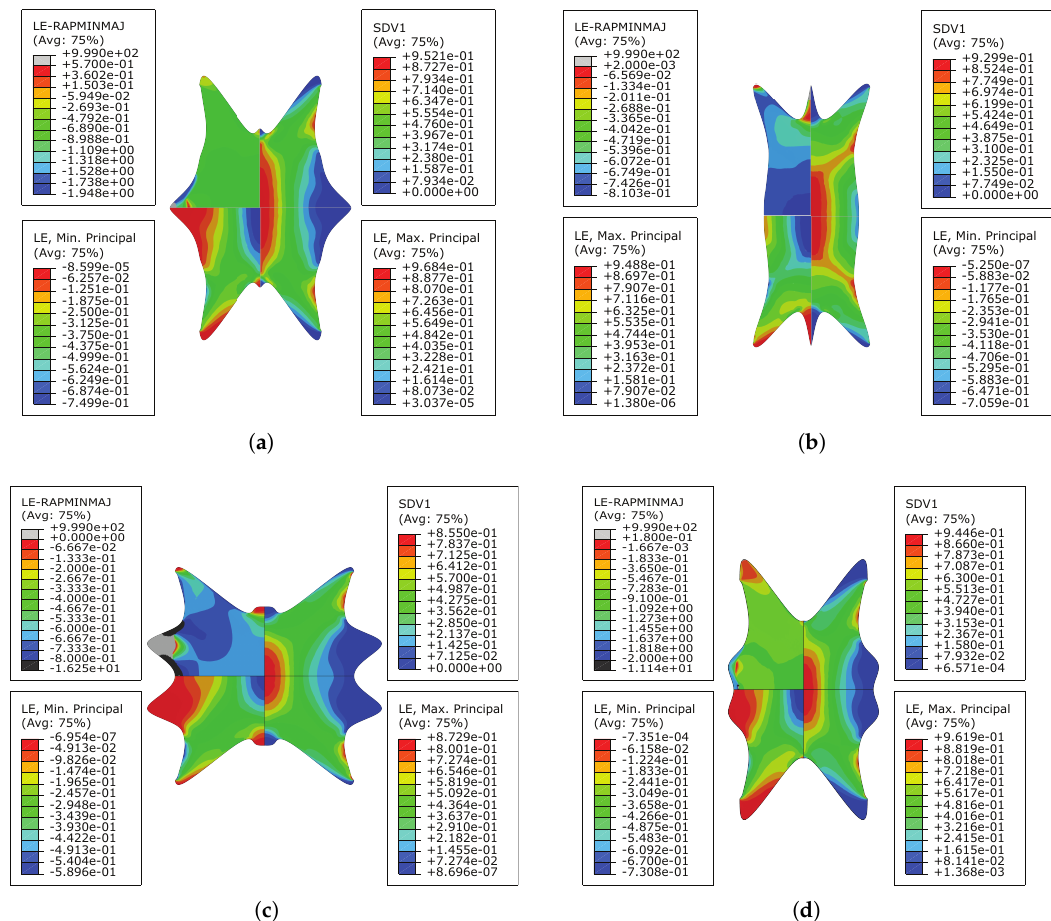
Figure 6. Distribution of ε p , ε 2 / ε 1 (corresponding to SDV1 and LE-RAPMINMAJ, respectively), and the major ε 1 and minor strains ε 2 over the specimens surfaces. ( a ) CMA-ES and ( b ) SDBOX with B-splines; ( c ) CMA-ES and ( d ) SDBOX with